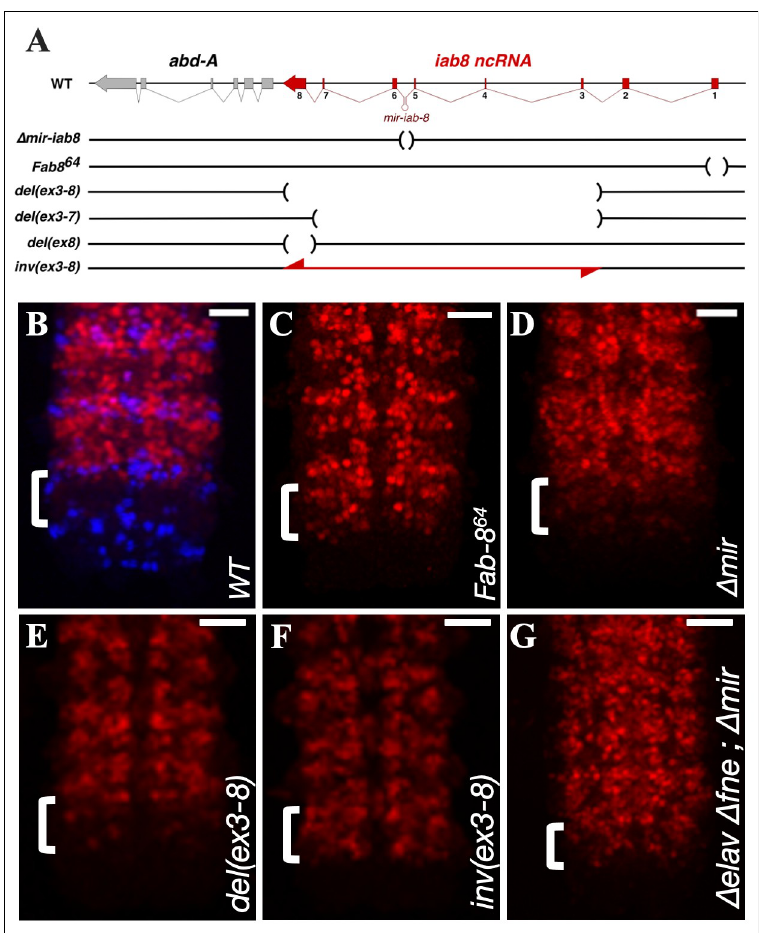
Fig 1. Deletions and inversions within the iab-8 ncRNA affect ABD-A expression in PS13. A. Shows a schematic representation (not to scale) of the mutants used in this study. Regions deleted are marked by parentheses in the horizontal line and the regions inverted are shown by a double-arrowed red line. B.-G. Shows Z-projection images made from confocal stacks of the posterior, stage 13/14 CNS stained with anti-ABD-A (red) and EN (blue in B. to show parasegments) Genotypes of the embryos are indicated at the bottom right corner of each panel. Scale bar = 20 μ m.